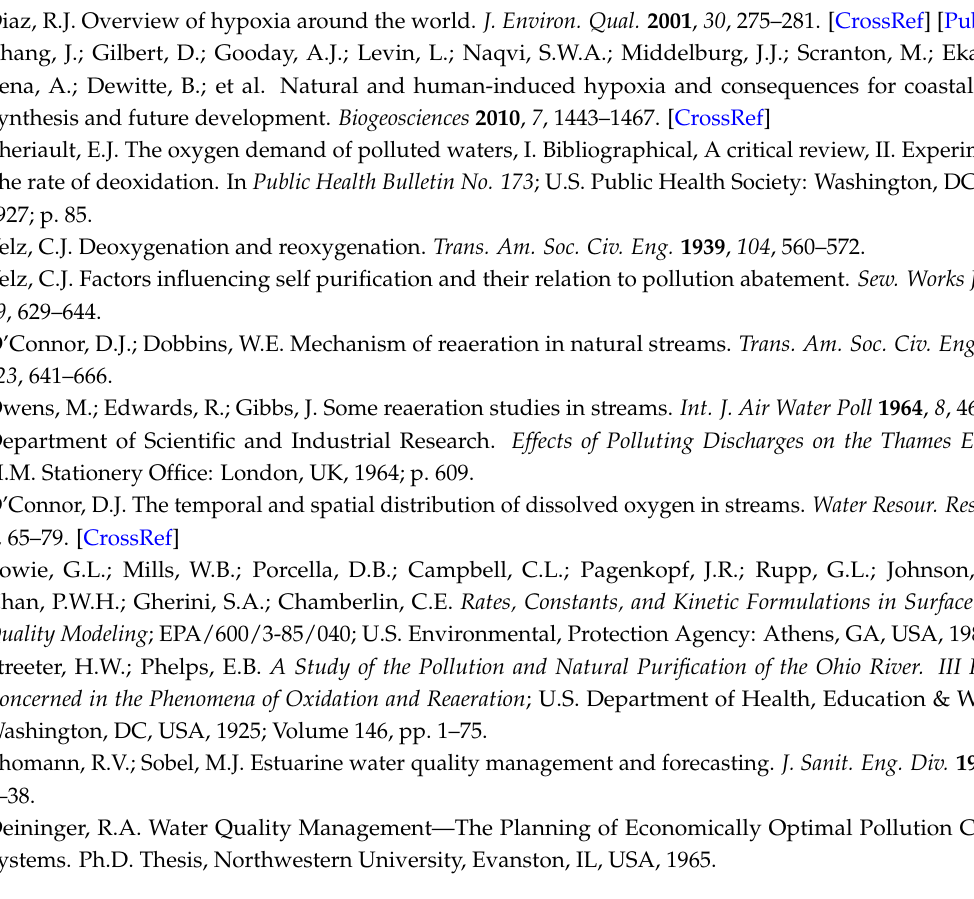
Figure S1: Hydrograph at site 16 in the Nanfei River in 2015, Figure S2: Measured SOD flux rates at sites 1, 2, 3, 4, 7, 14, 15 and 16, Figure S3: Derivation of CBOD deoxygenation rates and nitrification rates at sites 3 and